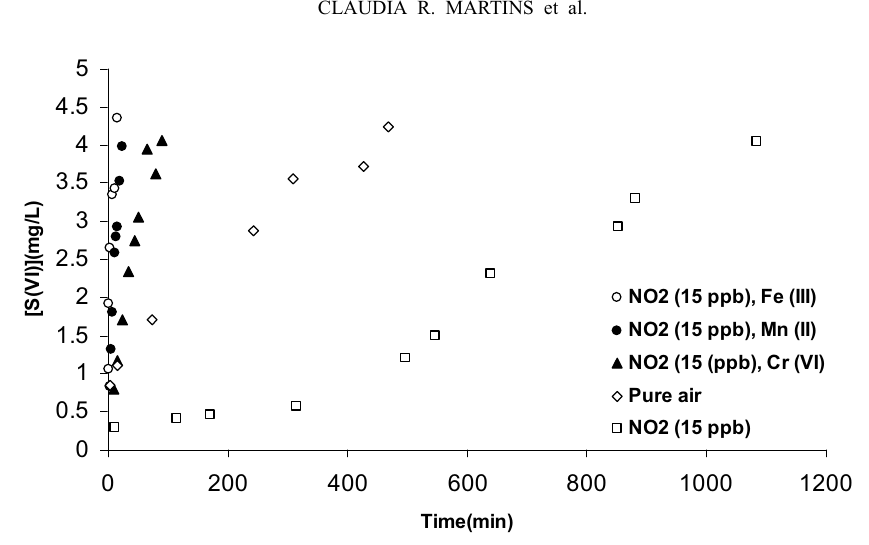
Fig. 4b – Time dependence of [S(VI)] for S(IV) oxidation, [S(IV)] ◦ = 8 mg/L, pH = 3.7, T = 22 ◦ C.